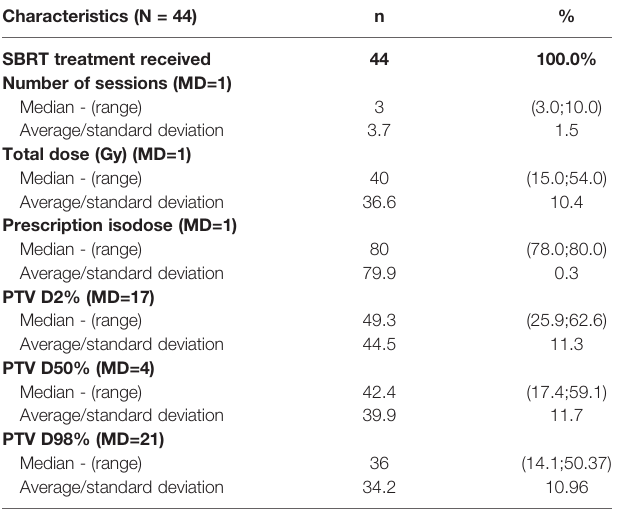
TABLE 2 | Characteristics of oligometastases treatments.